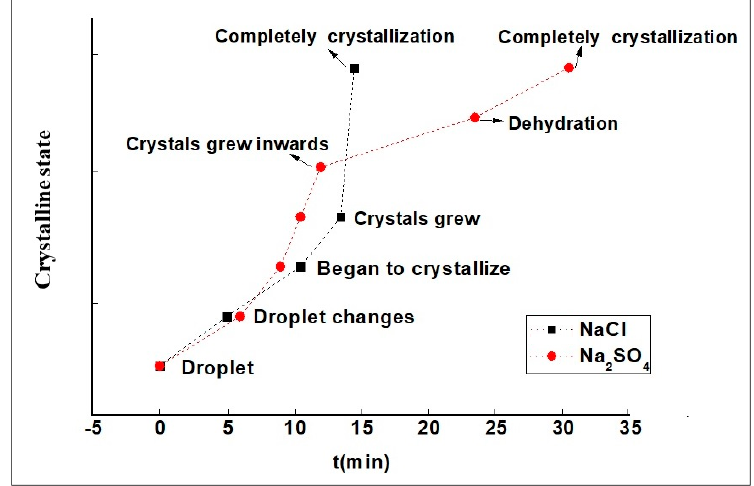
Figure 4. Time curve of salt droplets in di ff erent crystallization